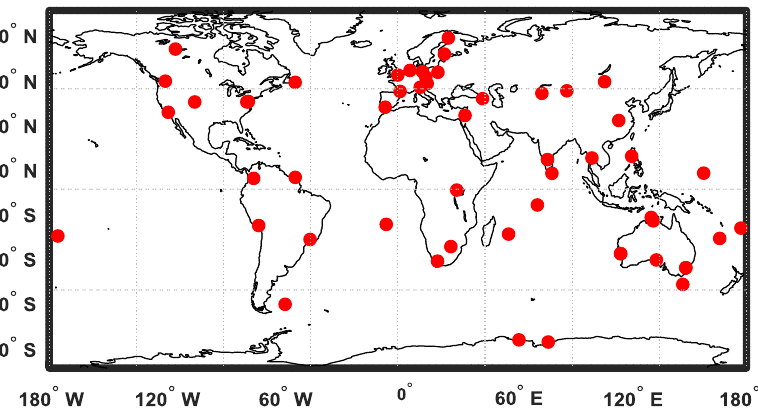
Figure 5. Fifty-four globally distributed IGS stations (including 13 JAVAD receivers and 41 SEPTENTRIO receivers).